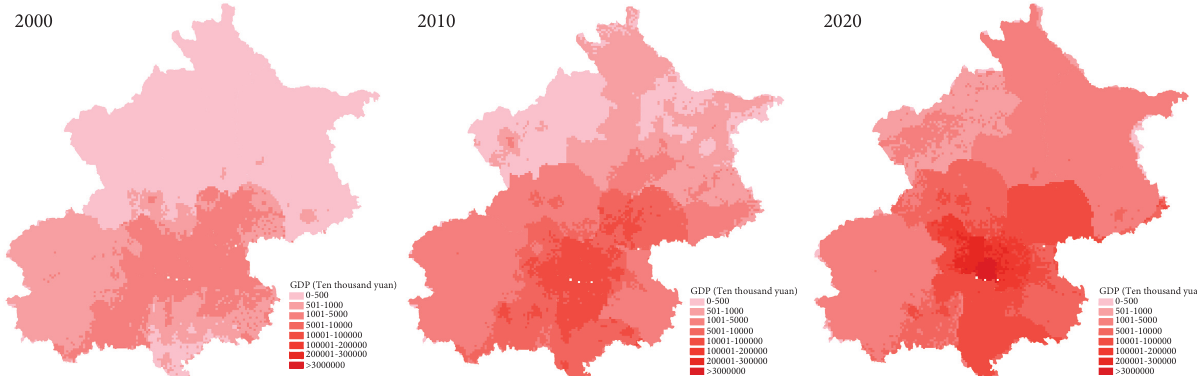
Figure 3: GDP development and change of Beijing